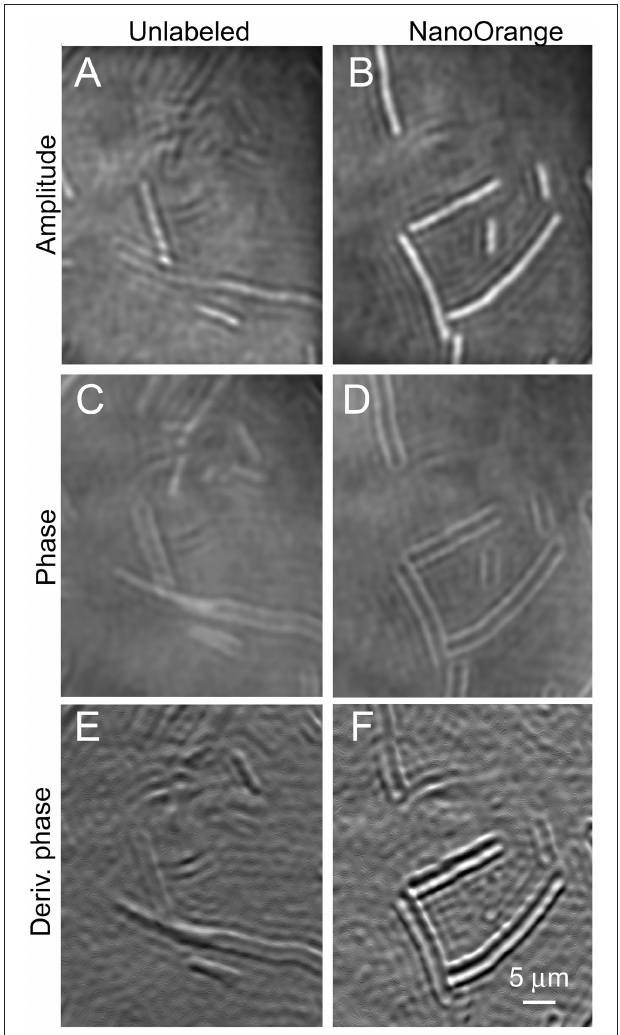
FIGURE 5 | Bacillus subtilis cells unlabeled (on the left) or incubated with NanoOrange (on the right). Scale bar applies to all panels. Phase range is –pi to pi. (A,B) Amplitude images. (C,D) Phase images. (E,F) First derivative of phase in x direction.